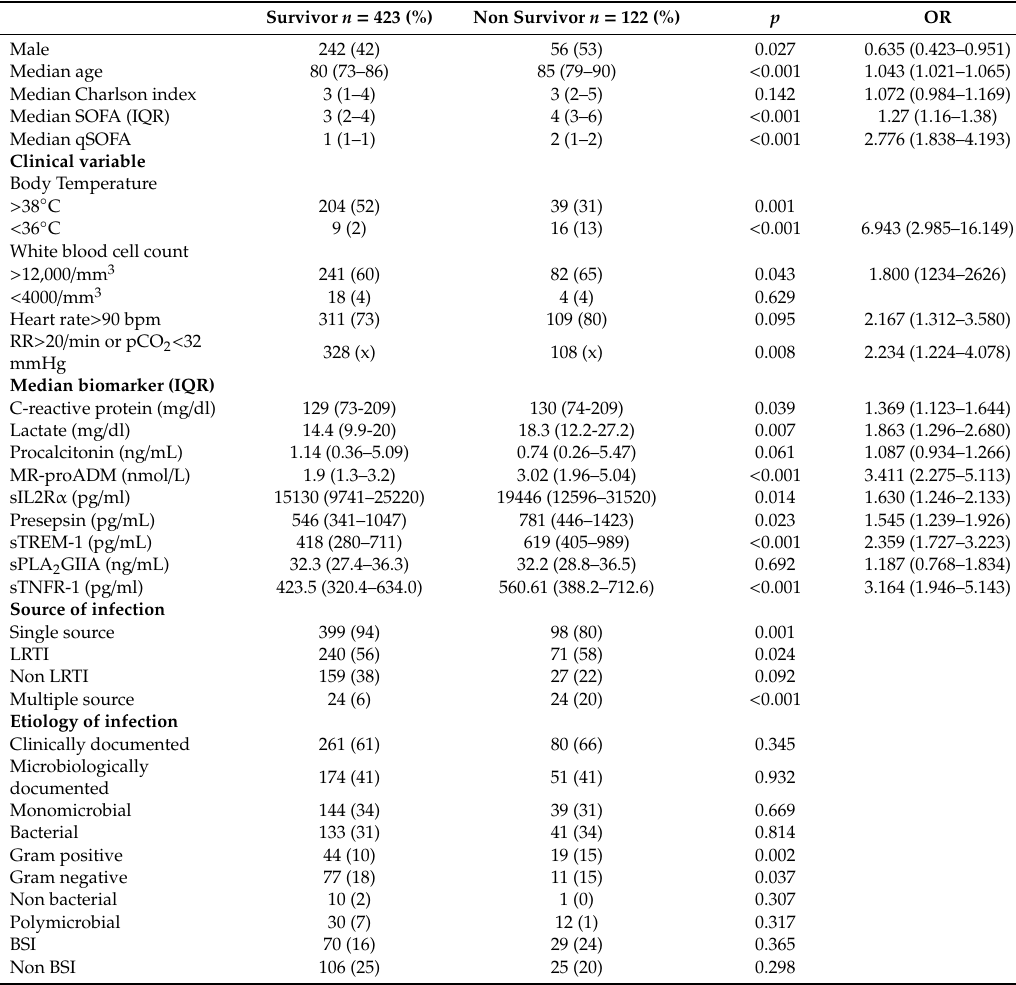
Table 3. Group 2: baseline patient characteristics, etiology, and source of infection at the end of the clinical work-up. Survivor n = 423